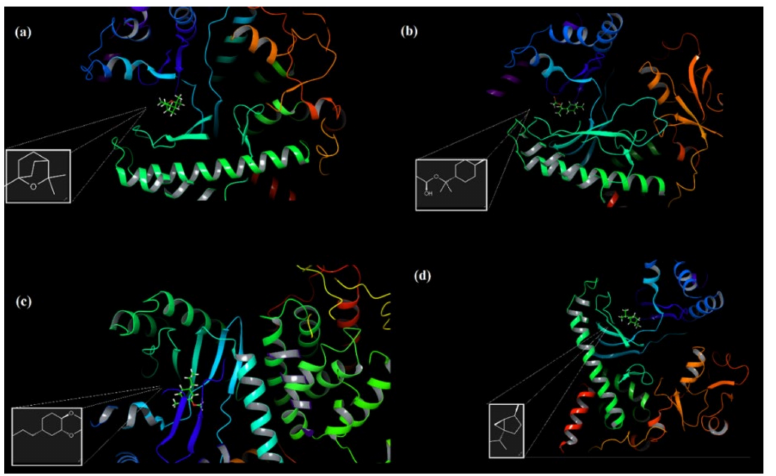
Figure 7. The docked pose of four major ingredients of LNEO: 1,8-cineole ( a ), α -terpinyl acetate ( b ), methyleugenol ( c ), and sabinene ( d